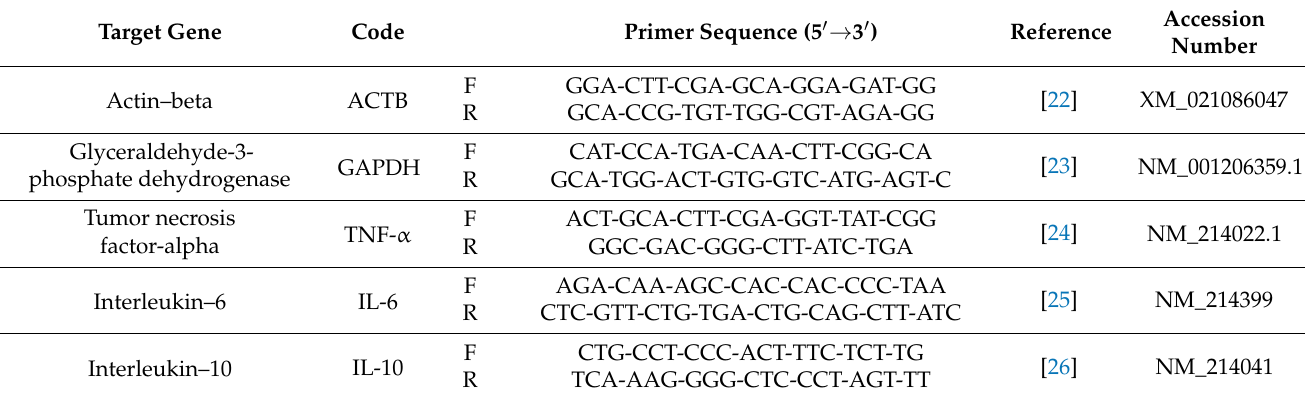
Table 2. Primers used for gene expression